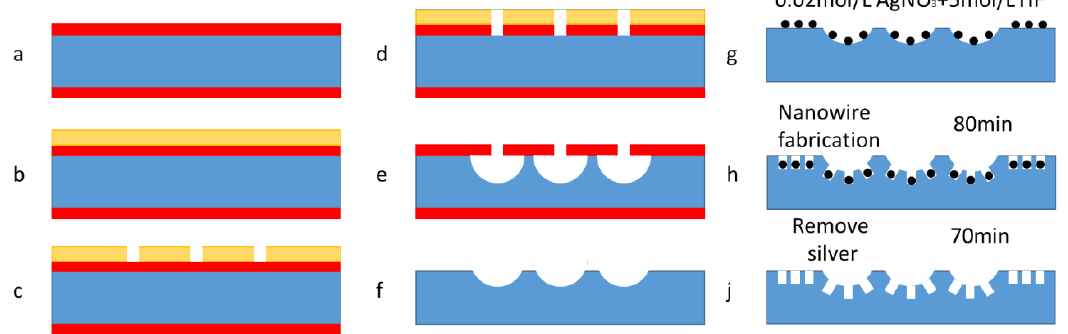
Figure 1. The process flow of secondary structures. ( a ) Piranha washing for 10 min, ( b ) spin coat photoresist, and prebake 30 min in nitrogen atmosphere oven, ( c ) pattern photoresist and post bake for 15 min in a nitrogen atmosphere oven, ( d ) using a buffer oxide etching fluid to etch silicon oxide, ( e ) piranha washing for 10 min to remove the photoresist, ( f ) silicon dioxide removed, ( g ) solution preparation, ( h ) solution (AgNO3/0.02-mol/L: HF/5-mol/L) configuring and soaking for 80 min, and ( j ) solution (HNO3/65%) configuring and soaking for 70 min.